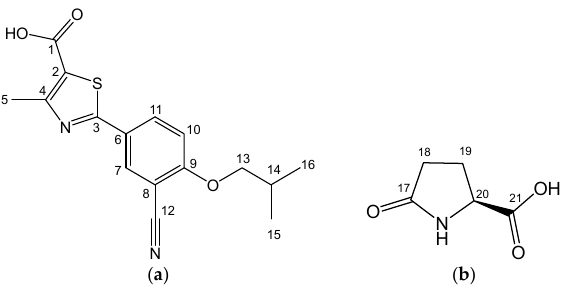
Figure 1. Molecular structure with atom numbers: ( a ) Febuxostat, ( b ) L -Pyroglutamic acid.